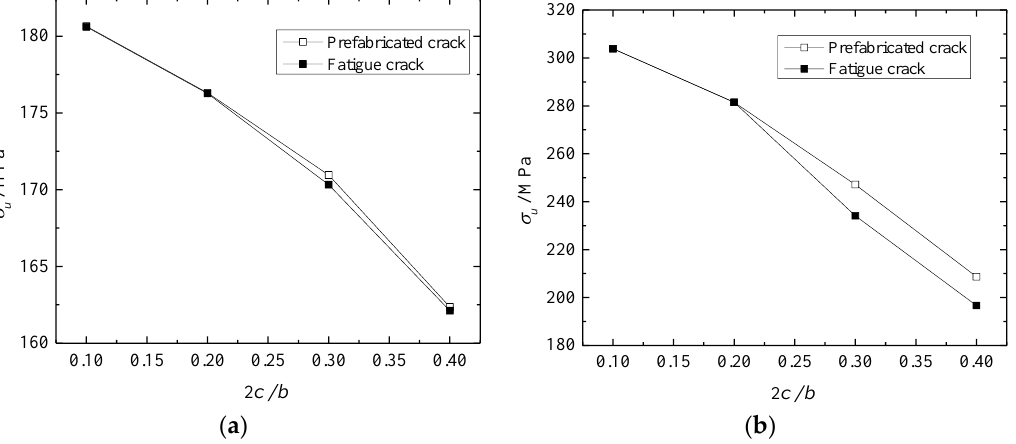
Figure 19. Residual strength at different crack lengths: ( a ) compressive residual strength; ( b ) tensile residual strength.